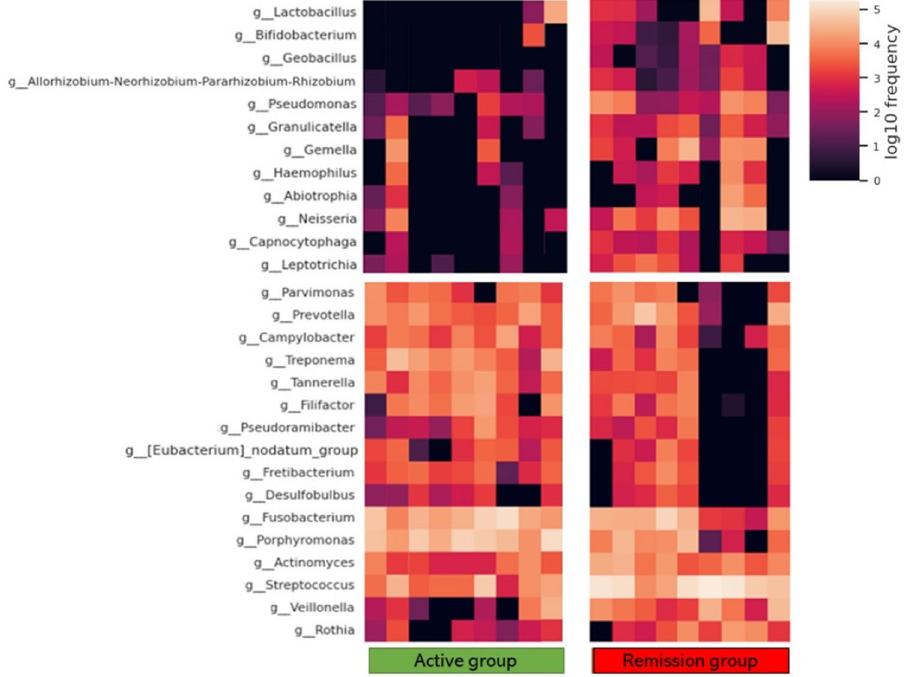
Figure 4. Heat map of relative abundance of the major bacteria in the two groups by taxa. Fusobacterium , Porphyromonas , and Streptococcus show high abundance and taxa bar plot. Lactobacillus and Bifidobacterium tend be more abundant in the remission group than in the active group.